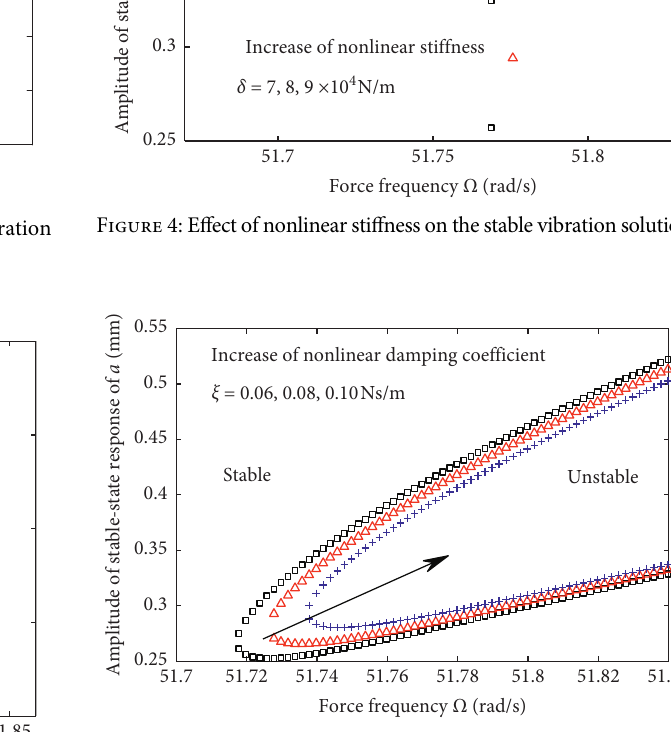
Figure 5: Effect of nonlinear damping on the solution’s stability region.